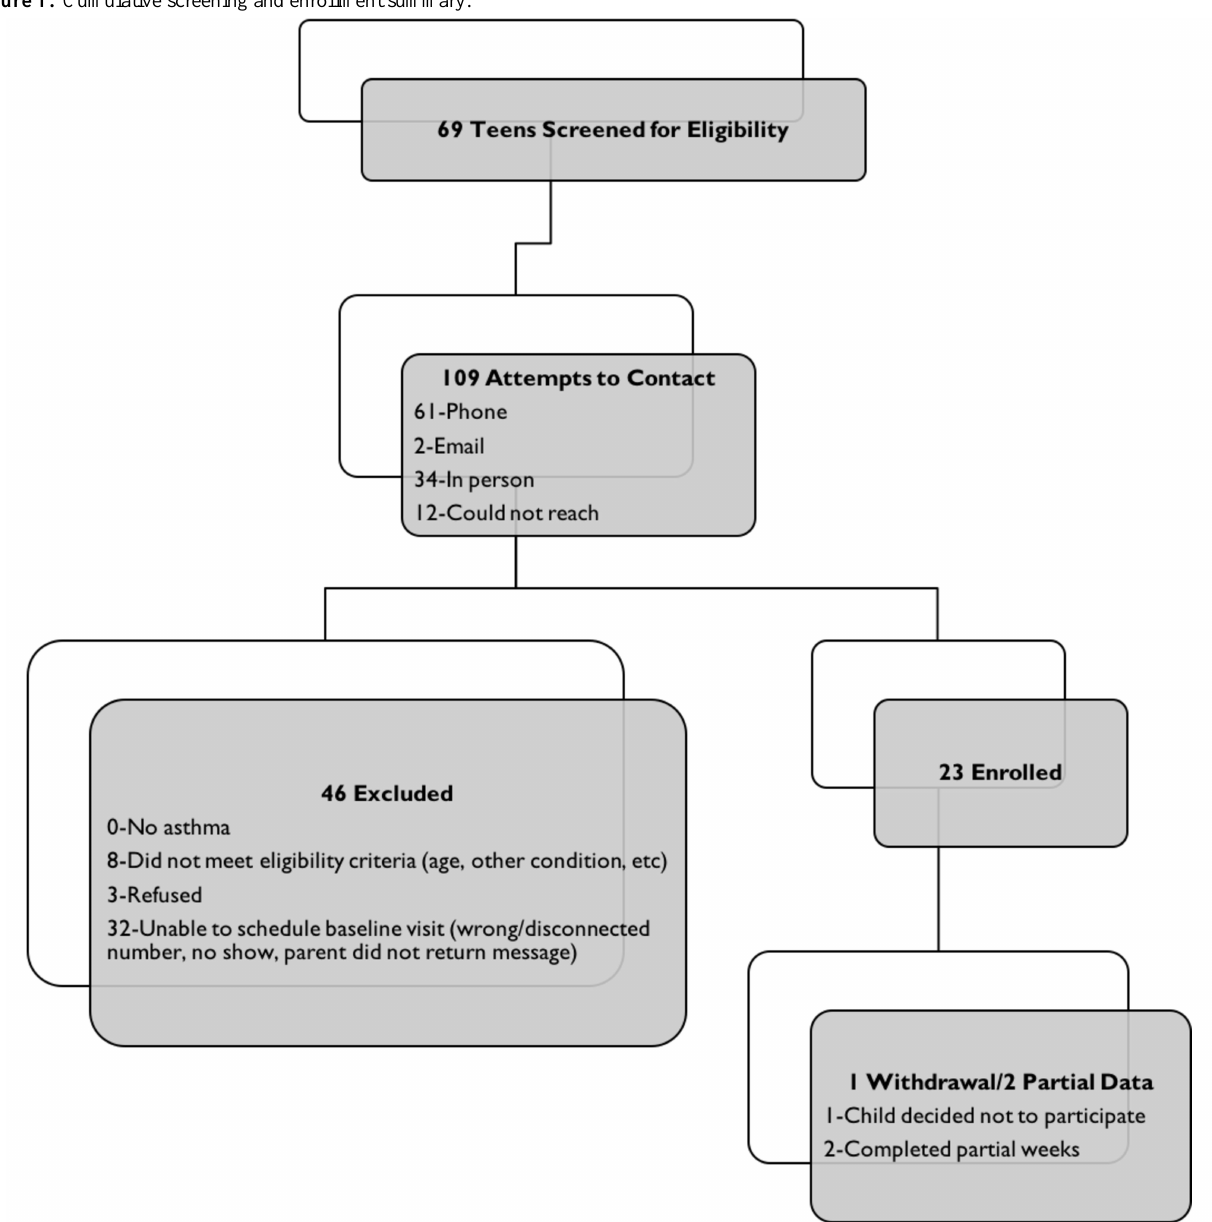
Figure 1. Cumulative screening and enrollment